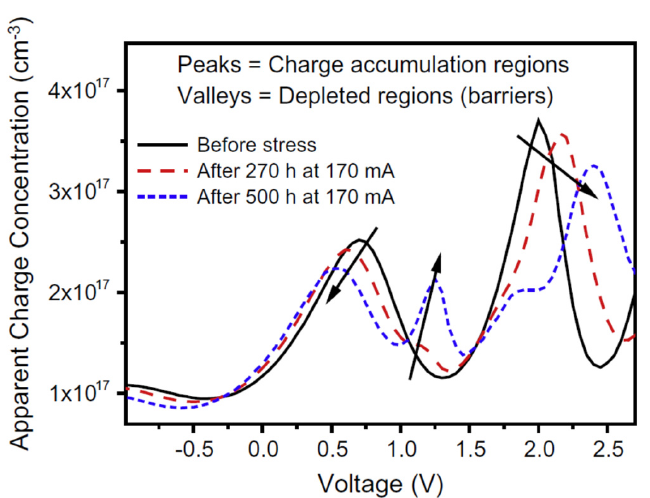
Figure 16. ACD profiles measured before and during stress at 170 mA. Reproduced with permis- sion. [54] Copyright 2010, Elsevier.